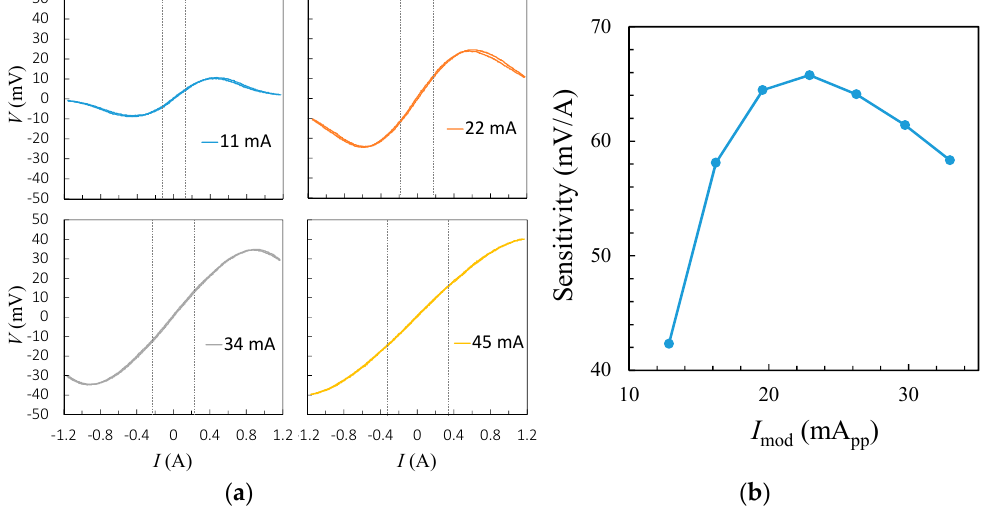
Figure 6. ( a ) Transfer curves of the GMR current sensor at modulation currents of 11, 22, 34, and 45 mA. The vertical dashed lines indicate the range of maximum nonlinearity less than 2%. ( b ) The sensitivities with respect to various modulation currents.